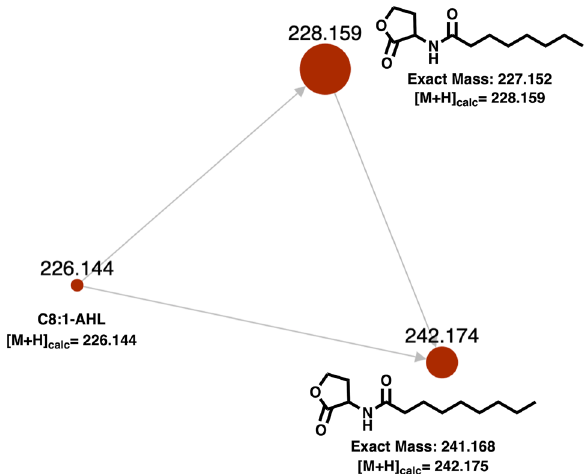
Figure 3. Molecular family from the molecular network of LC–MS/MS datasets from extracts of heterologous E. coli expressing AgpI rendered by GNPS (50). Detected m/z values from raw data positioned over each node with node diameter depicting associated intensities for each